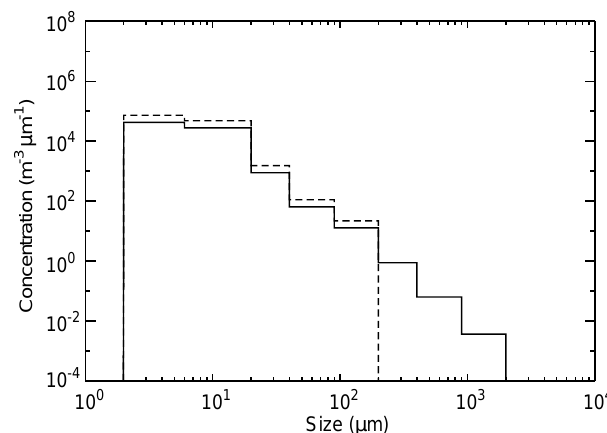
Table 2. Modelled size distribution of contrail particles. The particle concentration is 1.0 cm ) 3 , the ice water content 2.077 (cid:225) 10 ) 3 gm ) 3